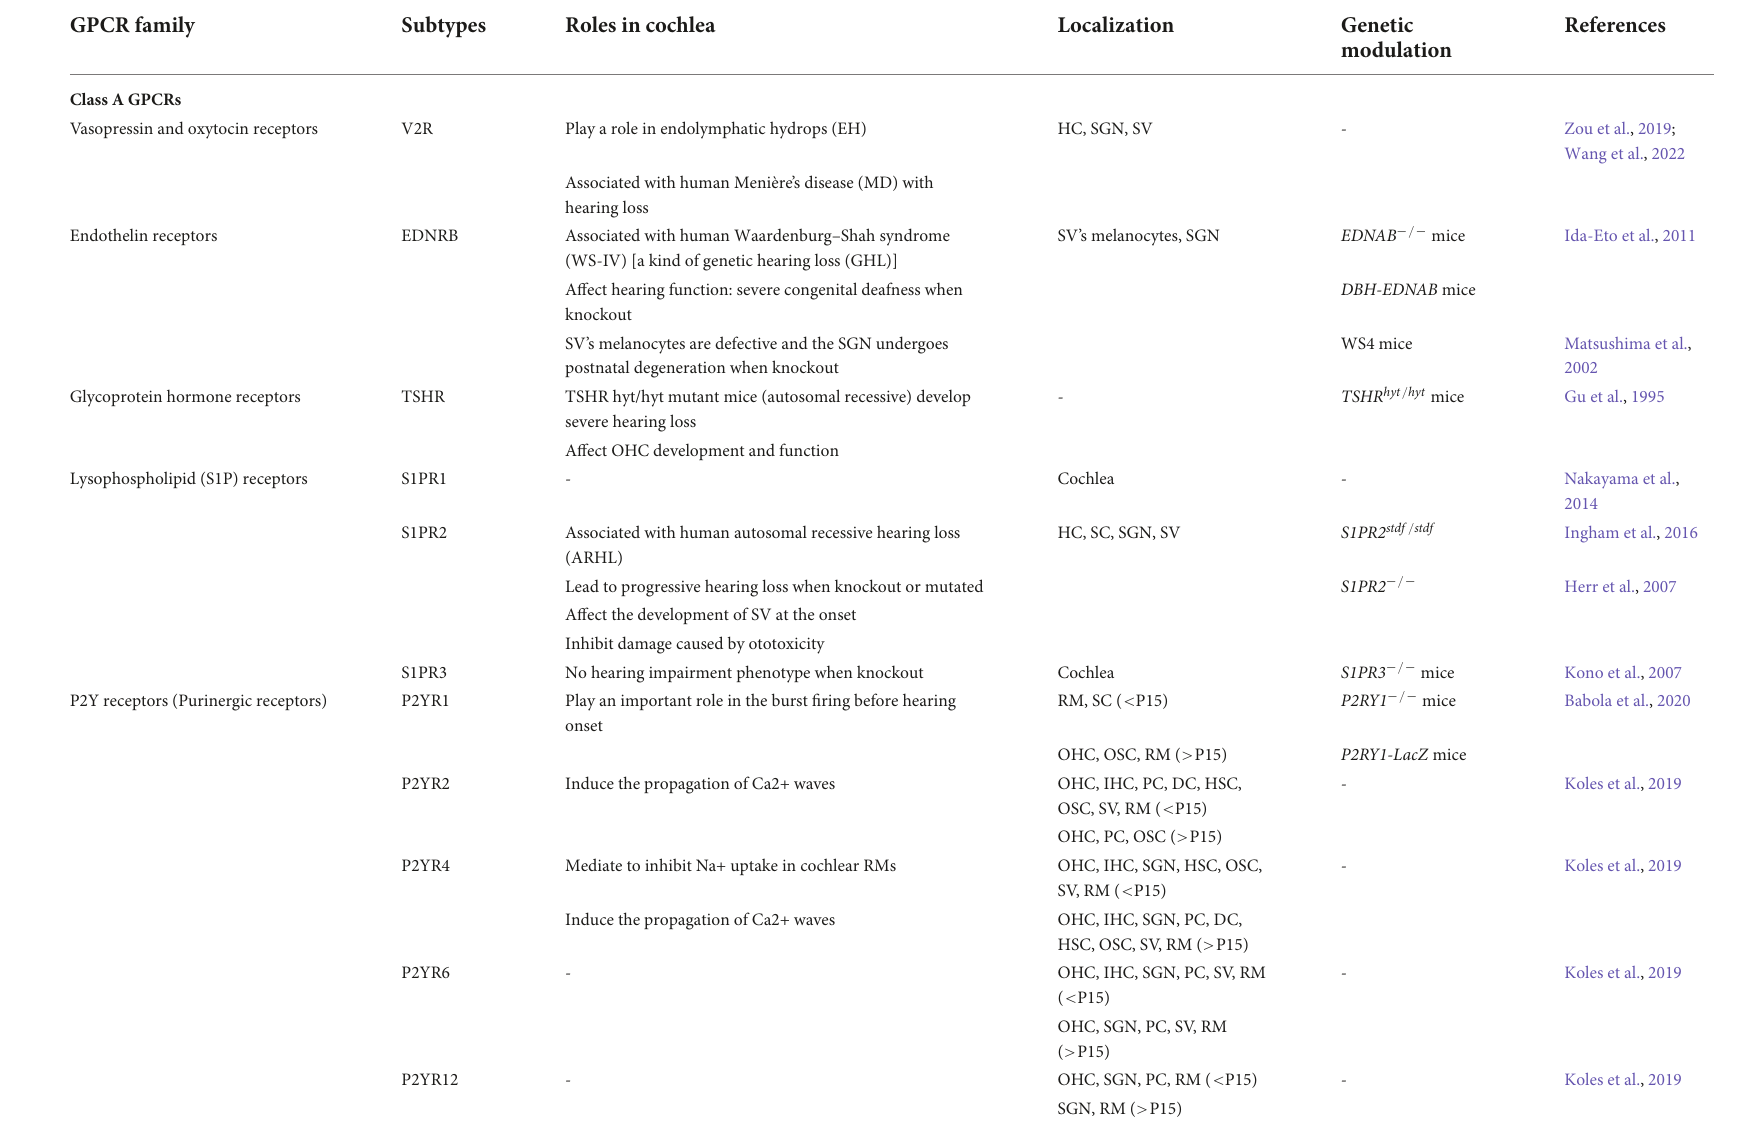
TABLE 1 Class A GPCRs relevant to